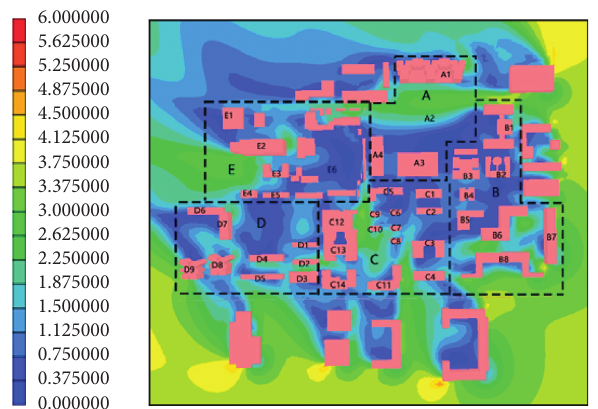
Figure 14: The wind velocity contour map at Z � 1.5m in